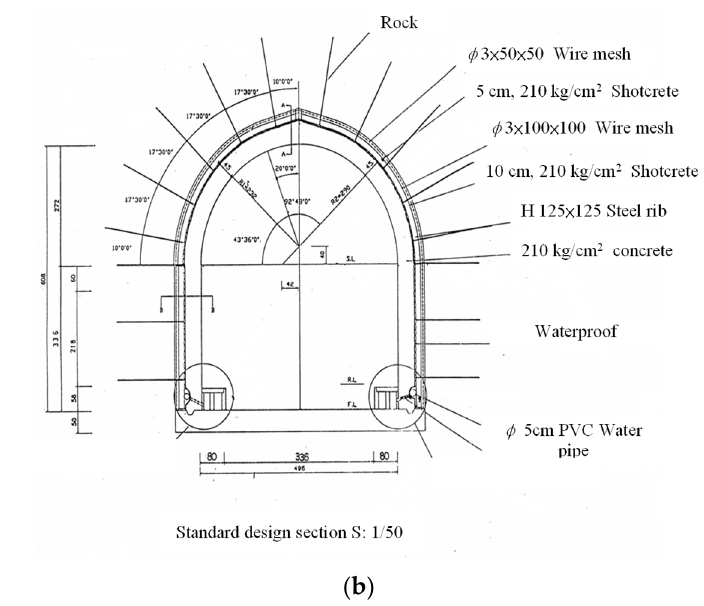
Figure 7. ( a ) Measurement points L1 and H1, and ( b ) standard design section of the observation section at tunnel face proximity of the New Youngchun and the New Nanao railway tunnels.